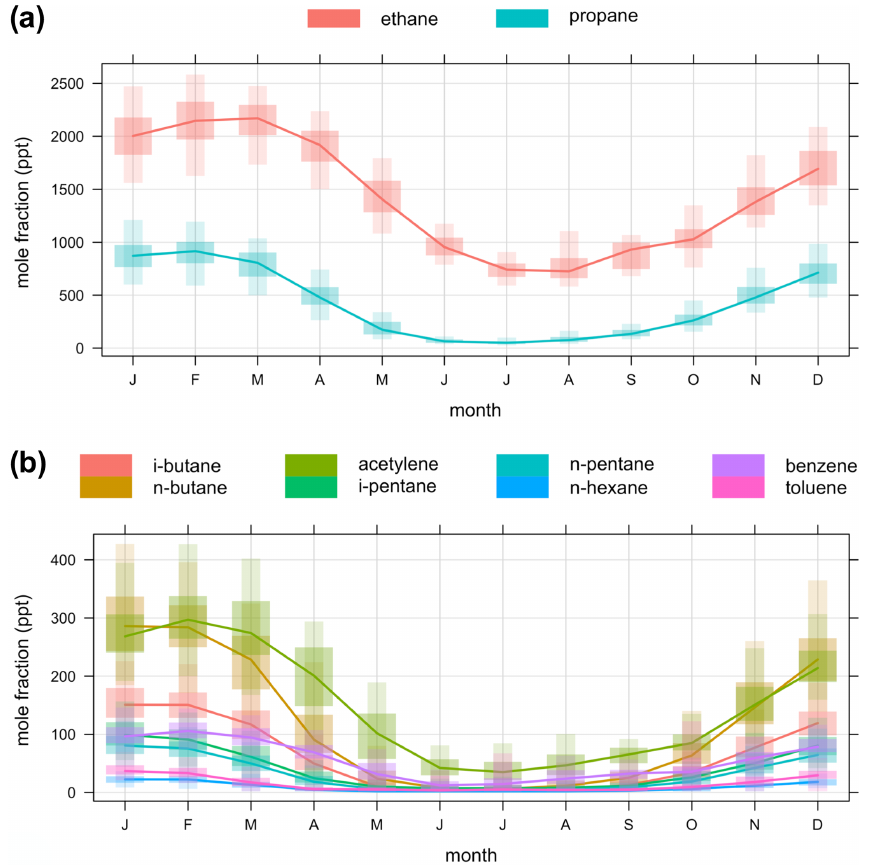
Figure 2. Monthly variation of (a) ethane and propane and (b) C 4 –C 7 non-methane hydrocarbons measured in ambient air at GEOSummit as inferred from 2008–2010 and 2012–2020 in situ measurements. In the monthly boxplots, the lower and upper end of the box correspond to the 25th and 75th percentiles, while the whiskers extend from the 5th to the 95th percentiles.